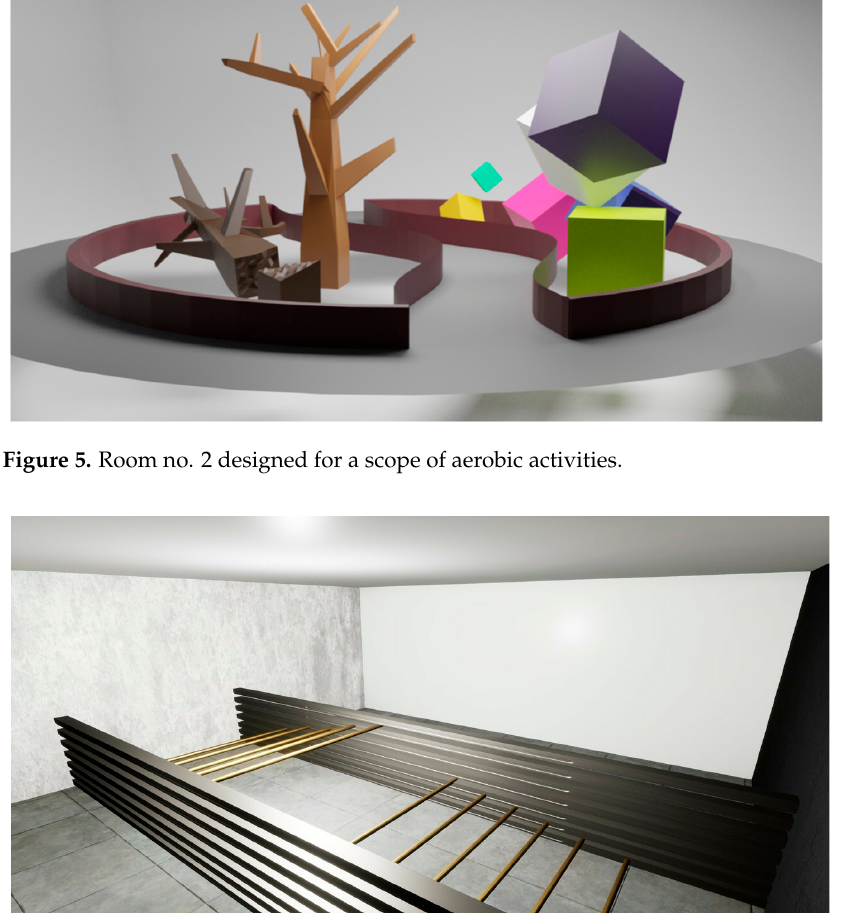
Figure 7. Room no. 4 designed for a scope of dual-task activities.